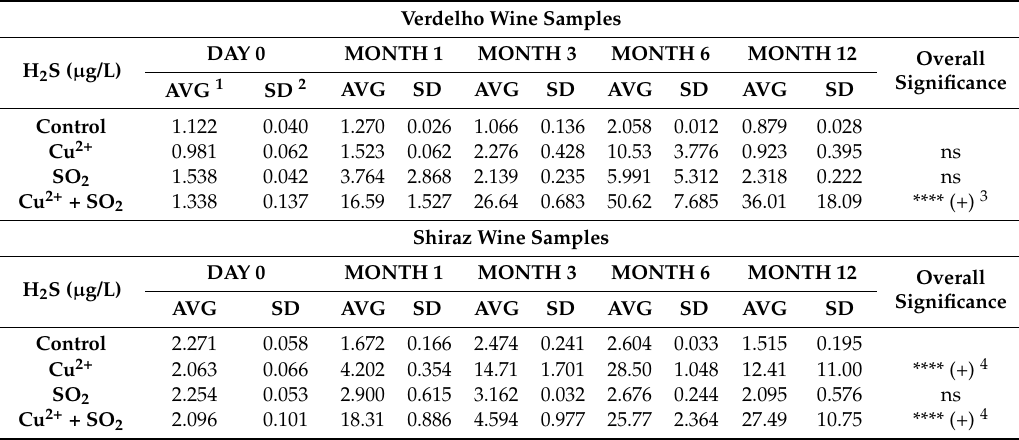
1 AVG: Average values for three replicates; 2 SD: Standard deviation values for three replicates; 3 p - value is the result of significance for the effect, “****” indicates p -value ≤ 0.001; 4 Significant effect associated with “Cu 2+ ” treatment.